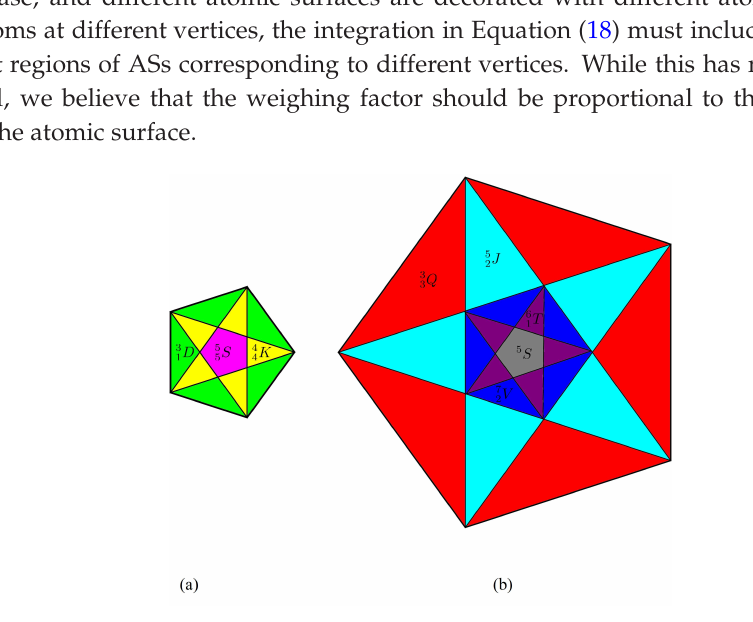
D , 5 S , 4 K ; ( b ) portions of 4 1